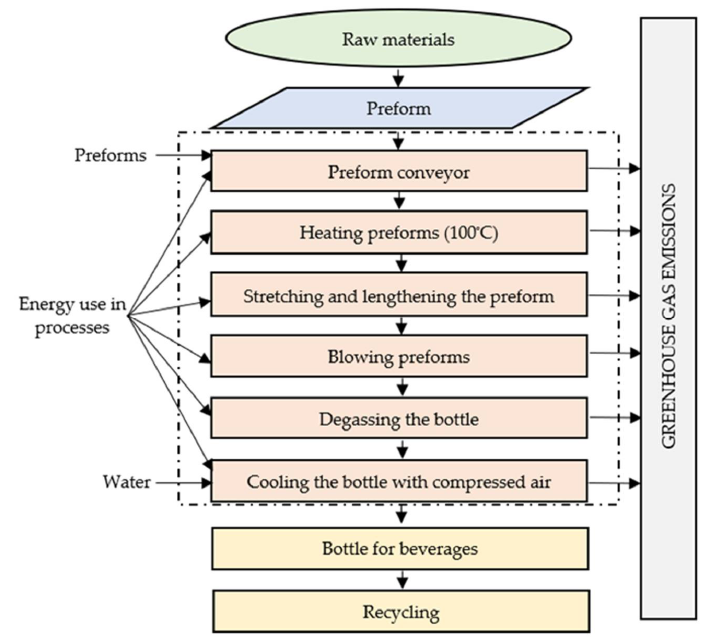
Figure 2. T he block diagram of the PET bottle production process. Figure 2. The block diagram of the PET bottle production